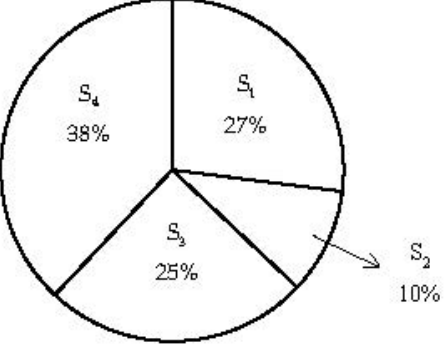
Figure 5. Distribution of contributed efforts in various emission sectors. Table 12. Contributed efforts in four emission